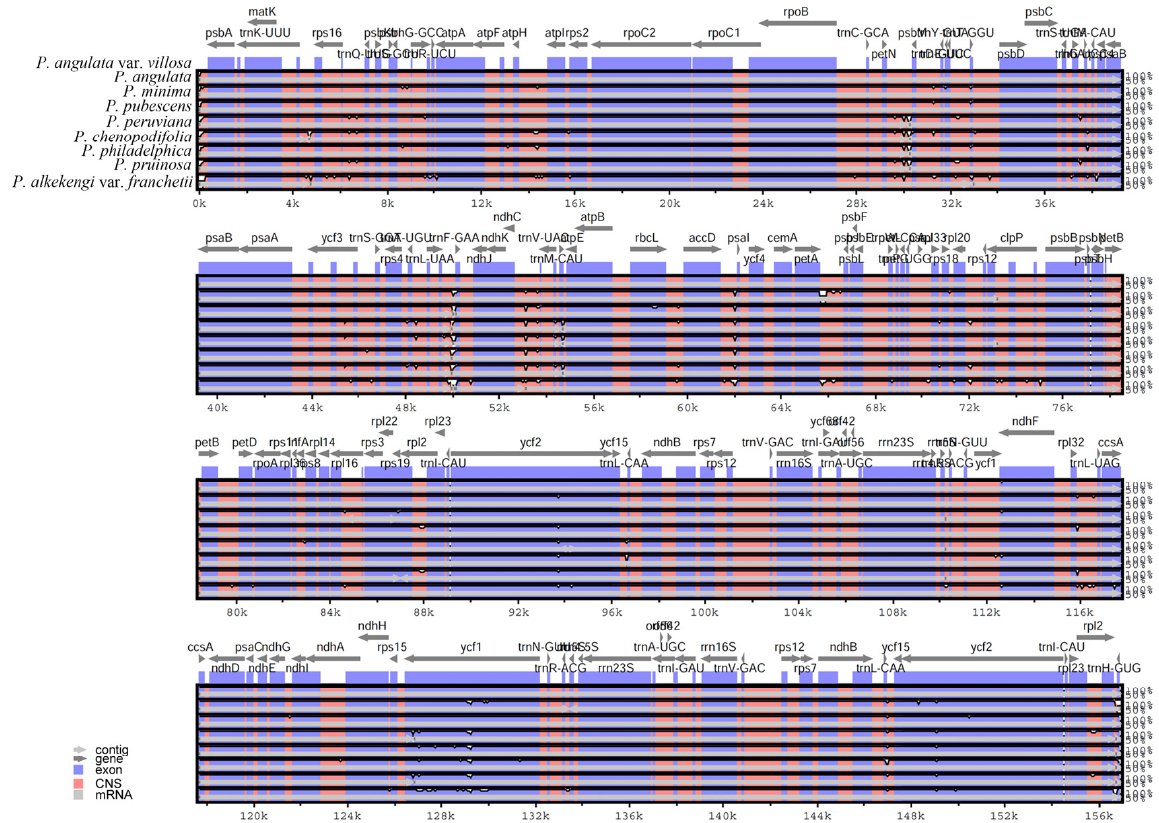
Figure 6. Sequence alignment of nine plastomes in the genus Physalis performed with mVISTA, using annotation of P. angulata var. villosa as reference. The y -axis presents the percentage identity, within 50–100%. Protein-encoding regions are indicated in blue and non-coding regions in red. A reduction in sequence identity is indicated by a reduction in the blue/red shadowing (white spaces).